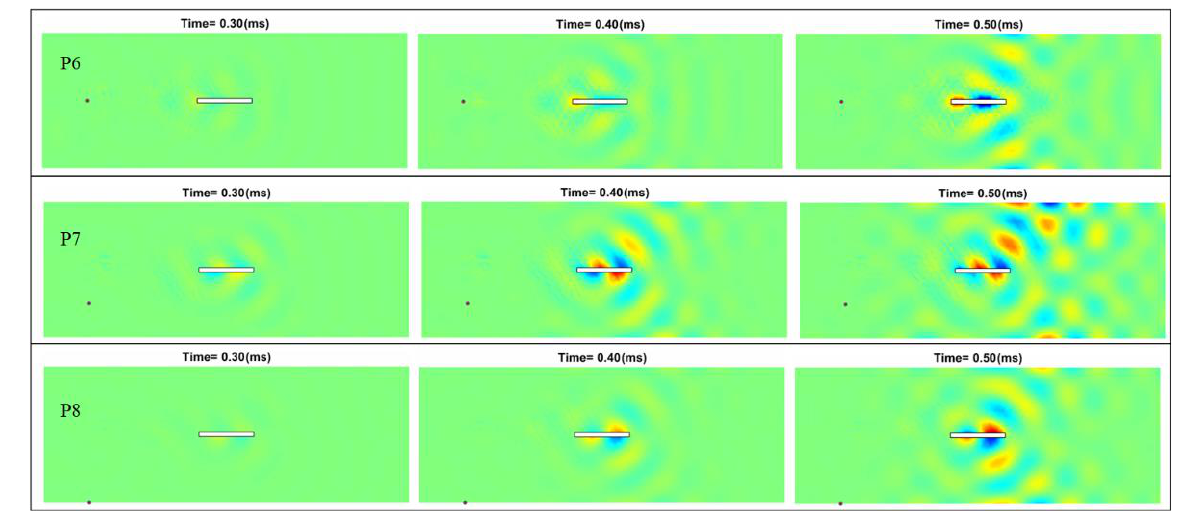
Figure 9. Differential instantaneous wave field when the pointwise excitations are at different locations from the left side of the damaged plate.